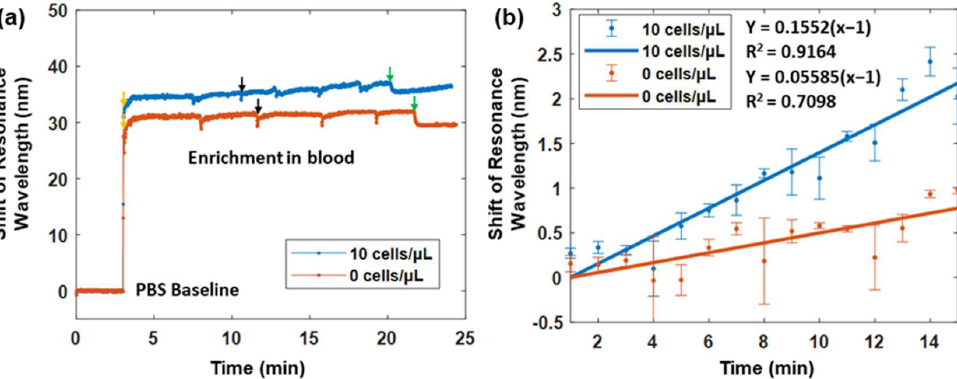
Figure 7. ( a ) SPR sensorgrams of the plasmonic fiber probe in the reciprocating whole mouse blood with a concentration of 10 MCF-7 cells/ µ L (blue line) versus that in the reciprocating mouse blood only (orange line). Both probes were first immersed in PBS solutions before the introduction of a reciprocating blood flow, as indicated with arrows. Black arrows indicate the change in flow direction by the peristaltic pump, and green arrows denote the halt of pumping. ( b ) The sensorgrams in ( a ) are smoothed through the averaging of each minute during the 15 min enrichment period. The blue and orange points denote the average sensing responses of two fiber probes in whole mouse blood with MCF-7 cells and without MCF-7 cells, respectively. The error bar refers to the standard deviation of the signal when one minute has passed. Linear fittings are performed in order to illustrate the sensing dynamics of two fiber probes in blood samples with MCF-7 cells (blue line) and without MCF-7 cells (orange line).